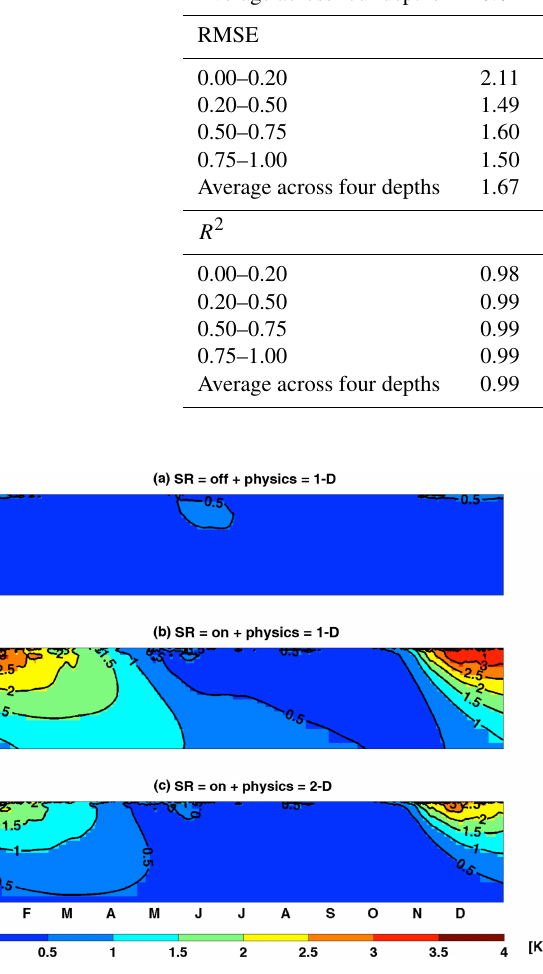
Figure 6. Simulated daily spatial standard deviation for each soil layer averaged across 10 years of near-surface soil temperature for the simulation performed with snow redistribution turned off and 1-D subsurface physics (a) ; snow redistribution turned on and 1-D subsurface physics (b) ; and snow redistribution turned on and 2-D subsurface physics (c) .